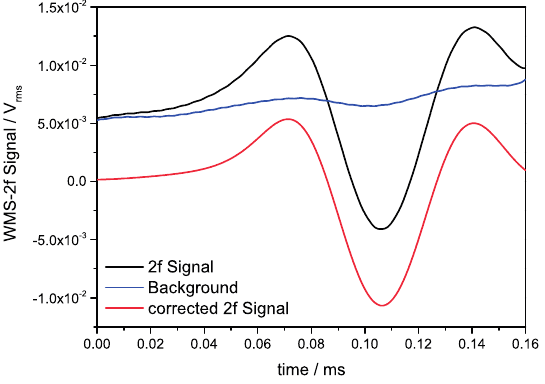
Figure 6. The demodulated 2f signal and corrected 2f signal after and before background subtraction.